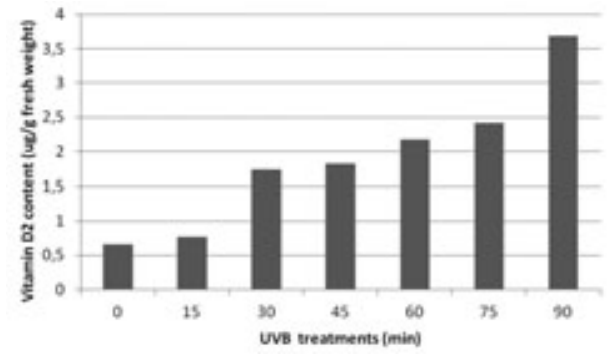
content in oyster mushrooms after 0 to 90 2